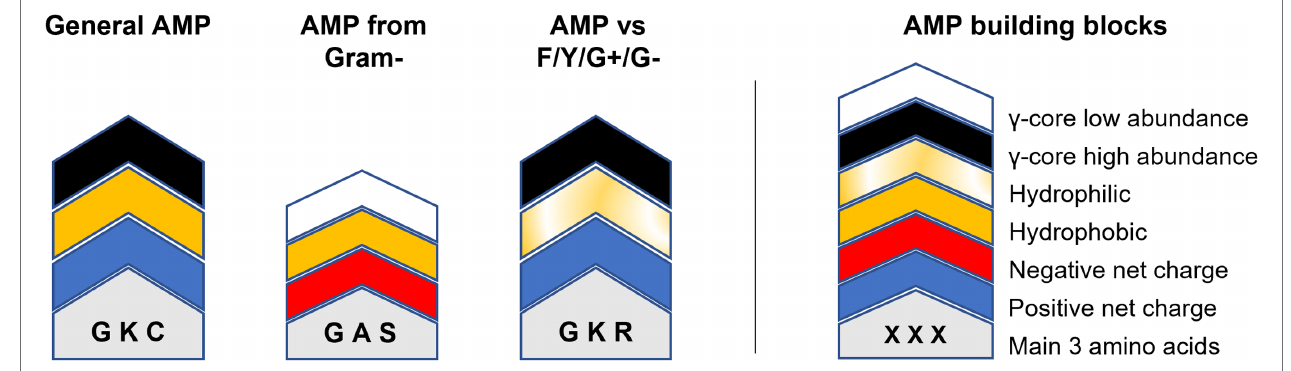
FIGURE 6 | Modular AMP design approach. Relevant building blocks determining the structural properties of AMPs are given on the right. The molecular weight/ length is indicated by the overall height of the building block stacks on the left which can be either higher or lower 2.5 kDa/20 residues. Amino acids are indicated by one-letter code. ‘General AMP’ displays the average structure retrieved from all analysed AMPs. ‘AMP from gram-’displays the average structure of all AMPs produced exclusively by Gram-negative bacteria. ‘AMP vs. F/Y/G+/G-’shows the main structural properties of AMPs with concurrent activities against filamentous fungi (F), yeast (Y), Gram-positive (G+) and Gram-negative (G-)